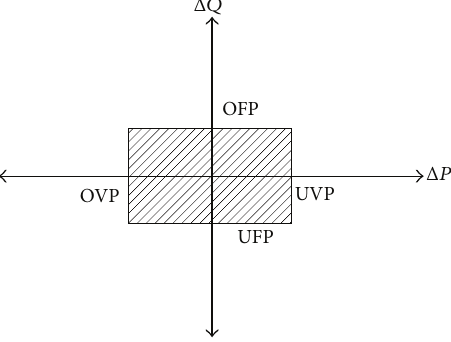
Figure 4: Nondetection zone